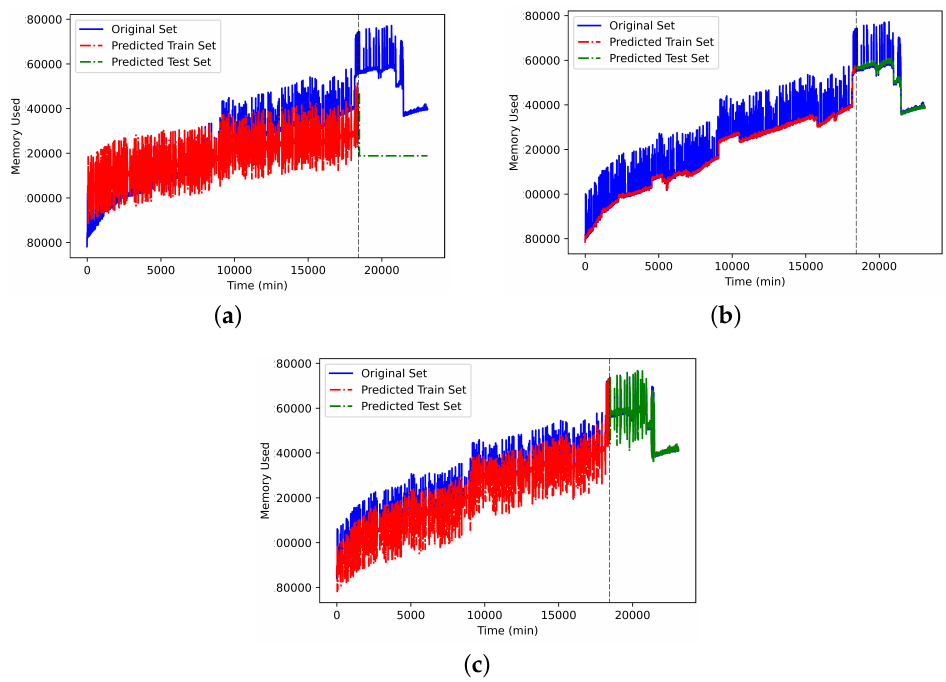
Figure 7. Graphics for data type “memory used with one VM”: ( a ) moving average; ( b ) Conv-LSTM; ( c ) proposed (moving average + Conv-LSTM).